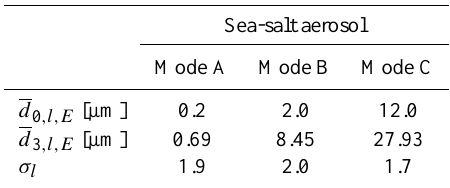
Table 1. Parameters for the lognormally distributed aerosol species. d 0 ,l,E ( d 3 ,l,E ) is the median diameter of the specific number (mass) emission of mode l . The standard deviation of mode l , σ l , is held constant for the whole